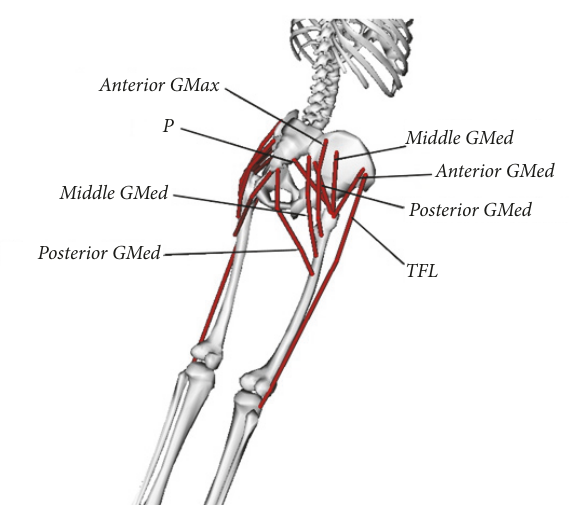
Figure 4: Schematic diagram of surrounding pelvic and hip muscles evaluated in the proposed procedure [9].